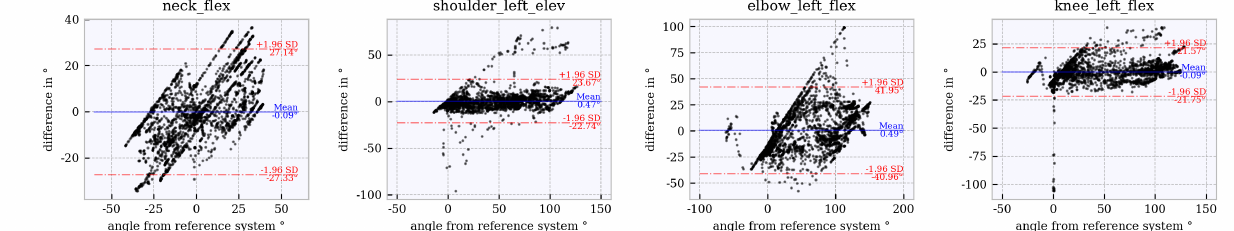
Figure 14. Bland–Altman plot for tracker configuration 6 ; x does not show the average of both systems but the joint angles of the reference system, Qualisys.